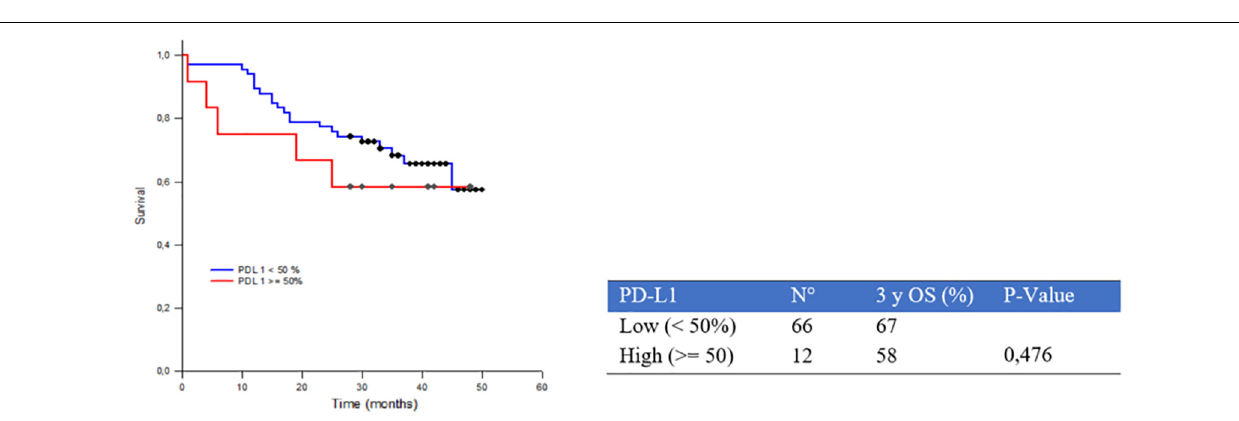
FIGURE 3 | Three-year survival rate (3yOS) data and curves according to low and high programmed death ligand 1 (PD-L1) Tumor Proportion Score (TPS)